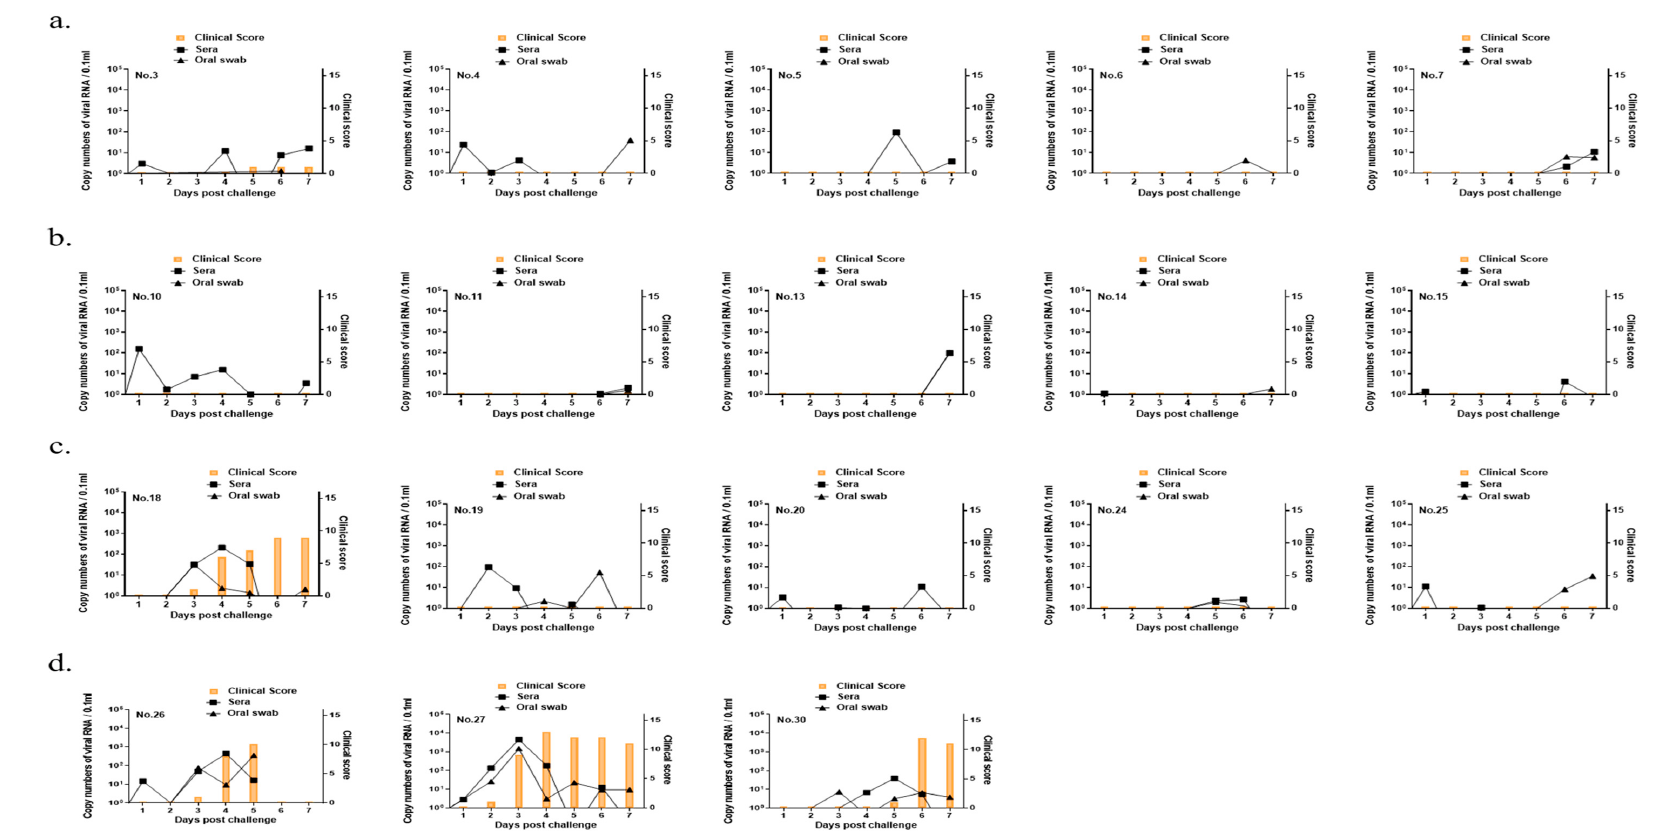
Figure 5. Clinical scores and virus shedding in pigs immunized with a bivalent vaccine after O/Boeun/SKR/2017 challenge. Oral swab and blood samples were collected daily from the pigs ( n = 18) that were vaccinated with the bivalent vaccine in the full dose ( a ), 1/3 dose ( b ), 1/9 dose ( c ), and control ( d ) groups until 7 days post-challenge. Clinical symptoms were examined daily after the virus challenge. The FMDV RNA was identified by extraction of viral RNA from oral swab samples and quantitative real-time polymerase chain reaction (RT-PCR).